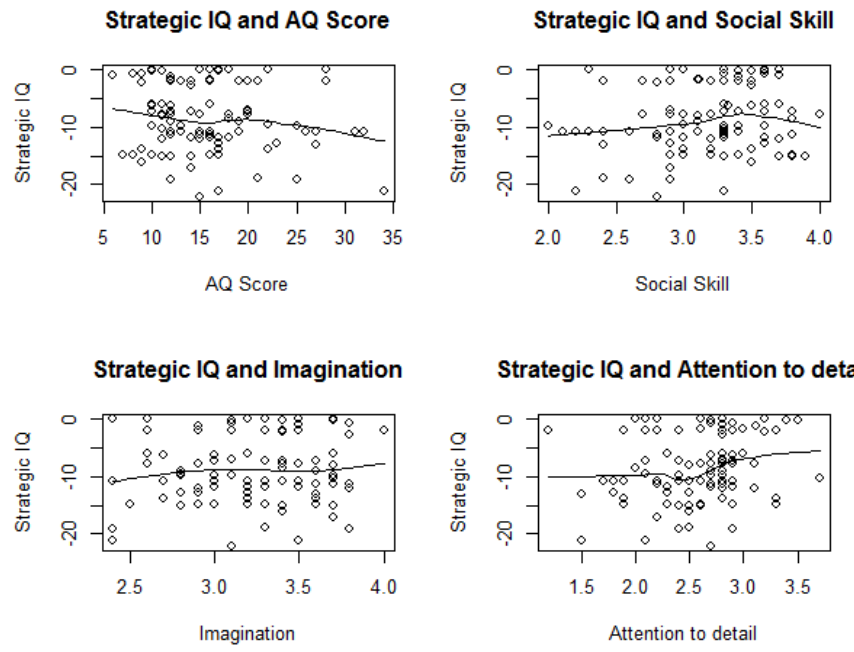
Figure 5. Strategic IQ as a function of AQ and subscales (for all L > 0). Table 5. Estimates of individual regression models predicting strategic IQ controlling for math skill and gender for Players L > 0 only.